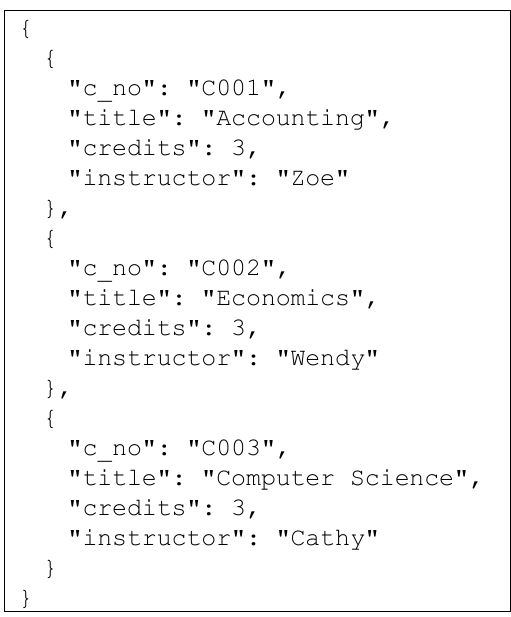
Figure 2. An example of a collection in a document store database.